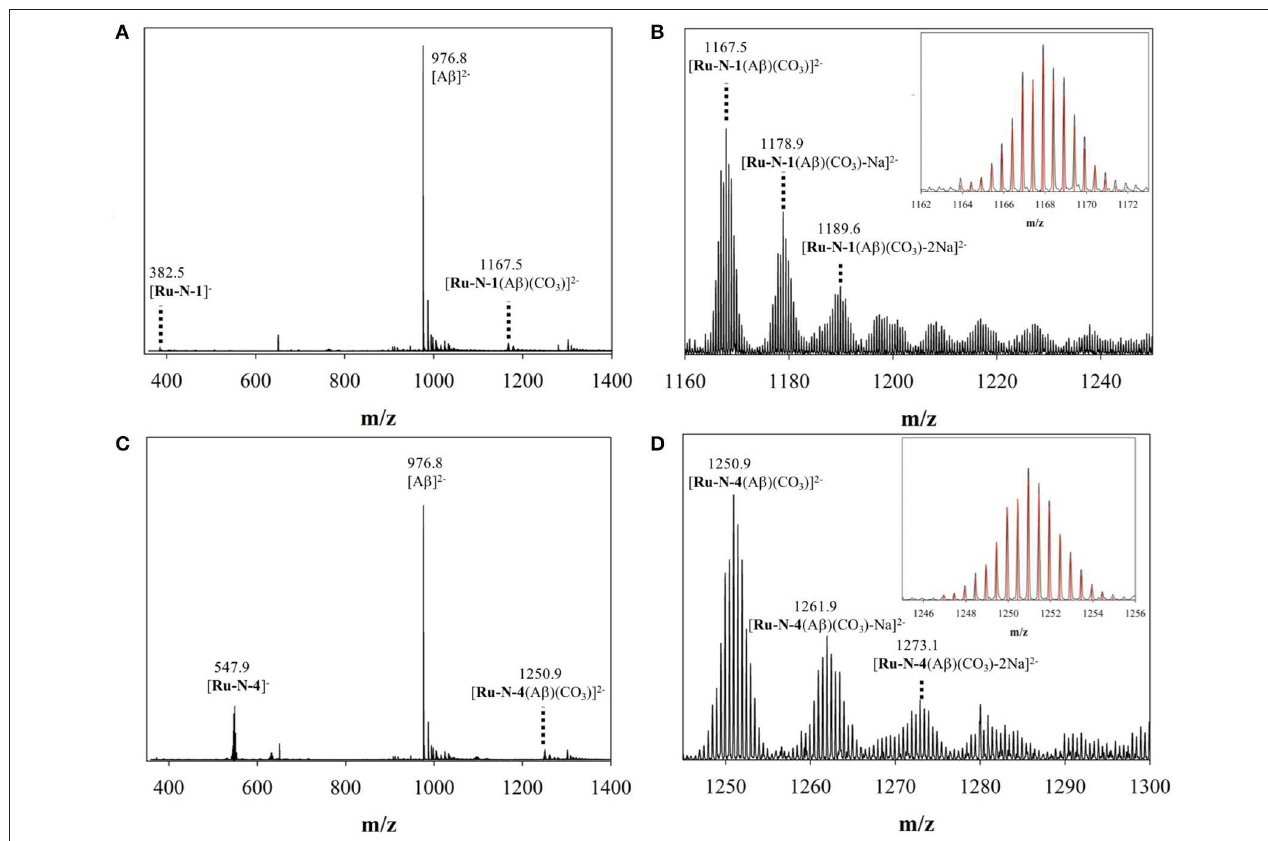
FIGURE 2 | ESI-MS of (A) binding of A β 1 − 16 to Ru-N-1 ; (B) zoomed region of [ Ru-N-1 (A β )(CO 3 )] 2 − with associated Na adducts; and (C) binding of A β 1 − 16 to Ru-N-4 ; (D) zoomed region of [ Ru-N-4 (A β )(CO 3 )] 2 − with associated Na adducts. Across all experiments, species were observed as [ Ru-N (0 − 1) (A β )(CO 3 )Na (0 − 6) ] 2 − .